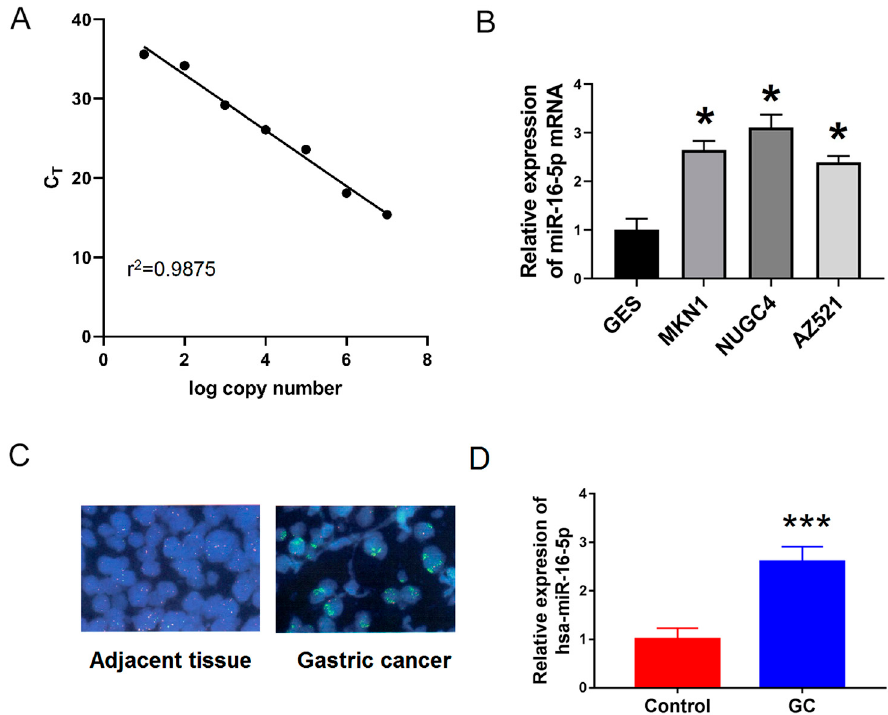
Figure 6. miR-16-5p was upregulated in GC cells and tissues. ( A ) Standard curves were constructed for miR-16-5p using qRT-PCR assay. ( B ) qRT-PCR was used to examine the relative levels of miR-16-5p in human MKN1, NUGC4 and AZ521) compared with that in GES-1 cells. ( C , D ) Fluorescence in situ hybridization (FISH) and qRT-PCR were used to examine the expression of miR-16-5p in 25 pair’s GC and adjacent tissues. * p < 0.05 vs. GES. *** p < 0.001 vs. control.